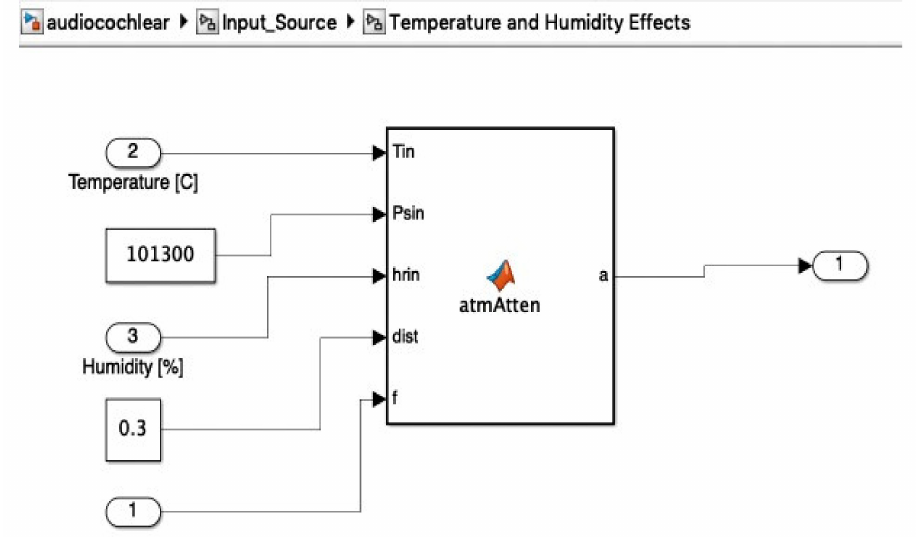
Figure 11. Detail of the temperature and humidity effects block, which uses the atmospheric attenua- tion